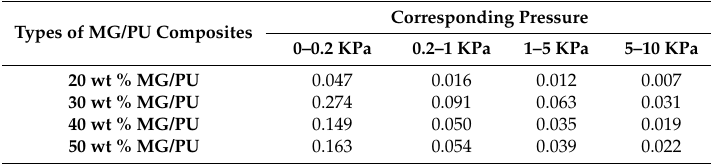
Table 4. Piezoresistive sensitivities of MG/PU composites (KPa − 1 ).